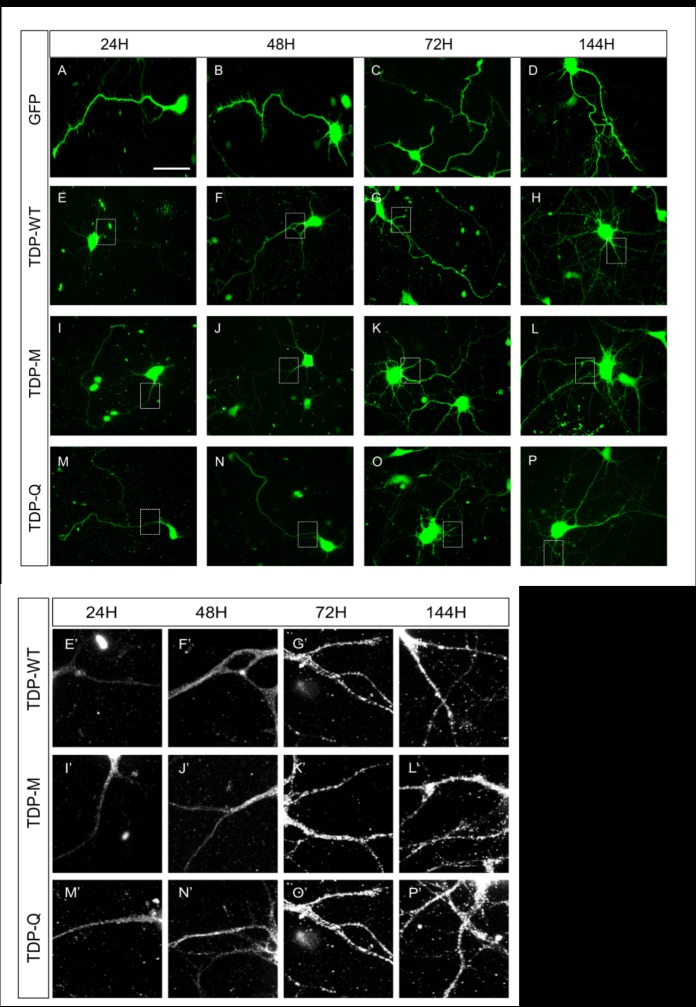
TDP-43 is mislocalised in cortical neurons.Rat cortical neurons were transfected with GFP control (A—D), and GFP-tagged TDP-43 wild-type and mutant isoforms (E—P) and analysed at 24–144 hours (H). Immunostained with anti-GFP antibodies. Scale bar = 10 µm. Insets (E’–P’)—higher power views of the corresponding panels above, converted to black and white pixels. Scale bar = 10 µm.